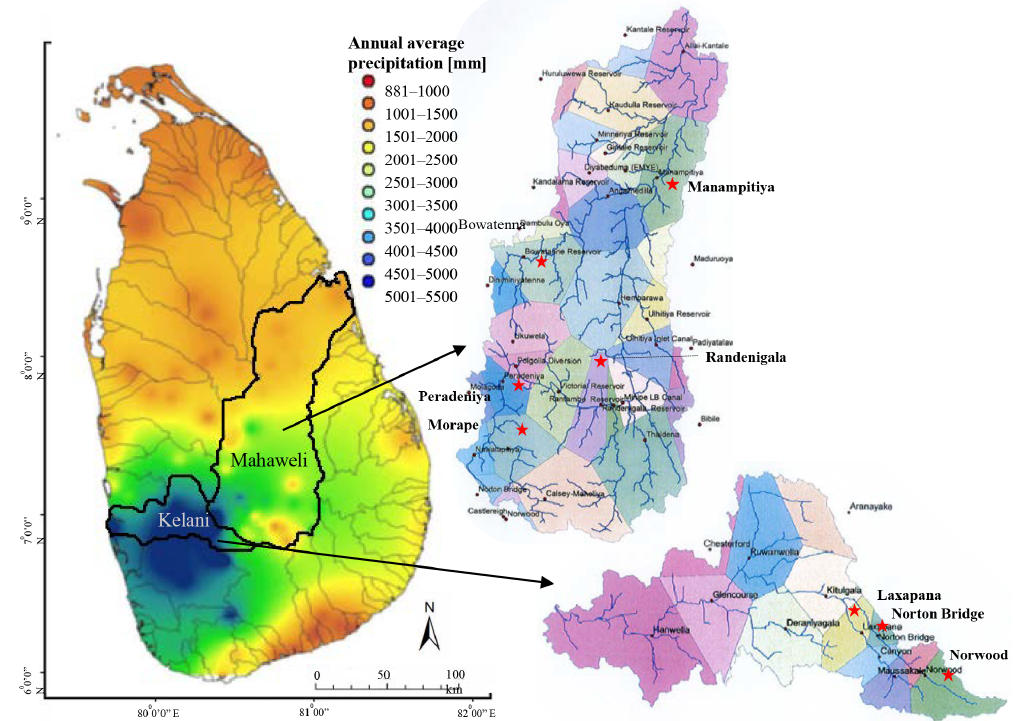
Figure 1. Mahaweli and Kelani River basins of Sri